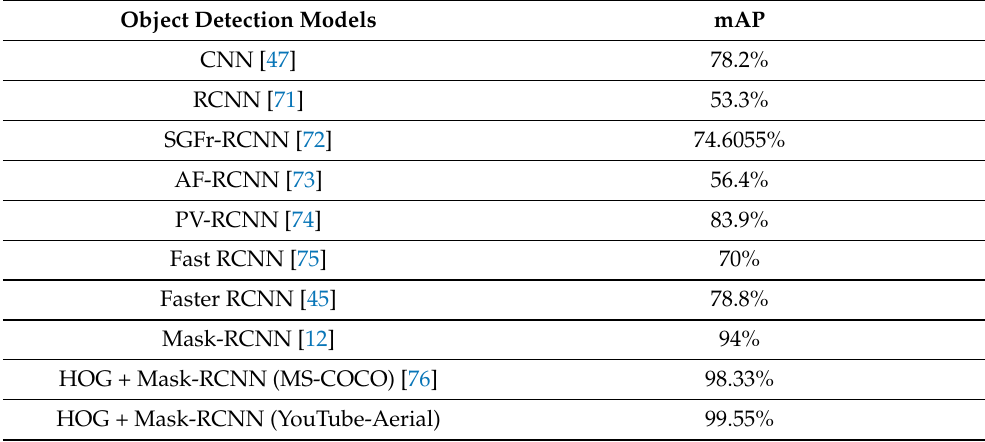
Table 2. Different object detection models with the percentage of